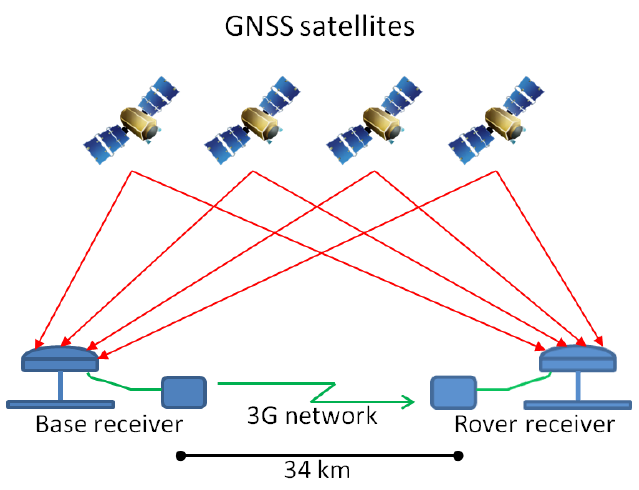
Figure 2. DGPS mode with 34 km baseline and 3G network for sending differential corrections over